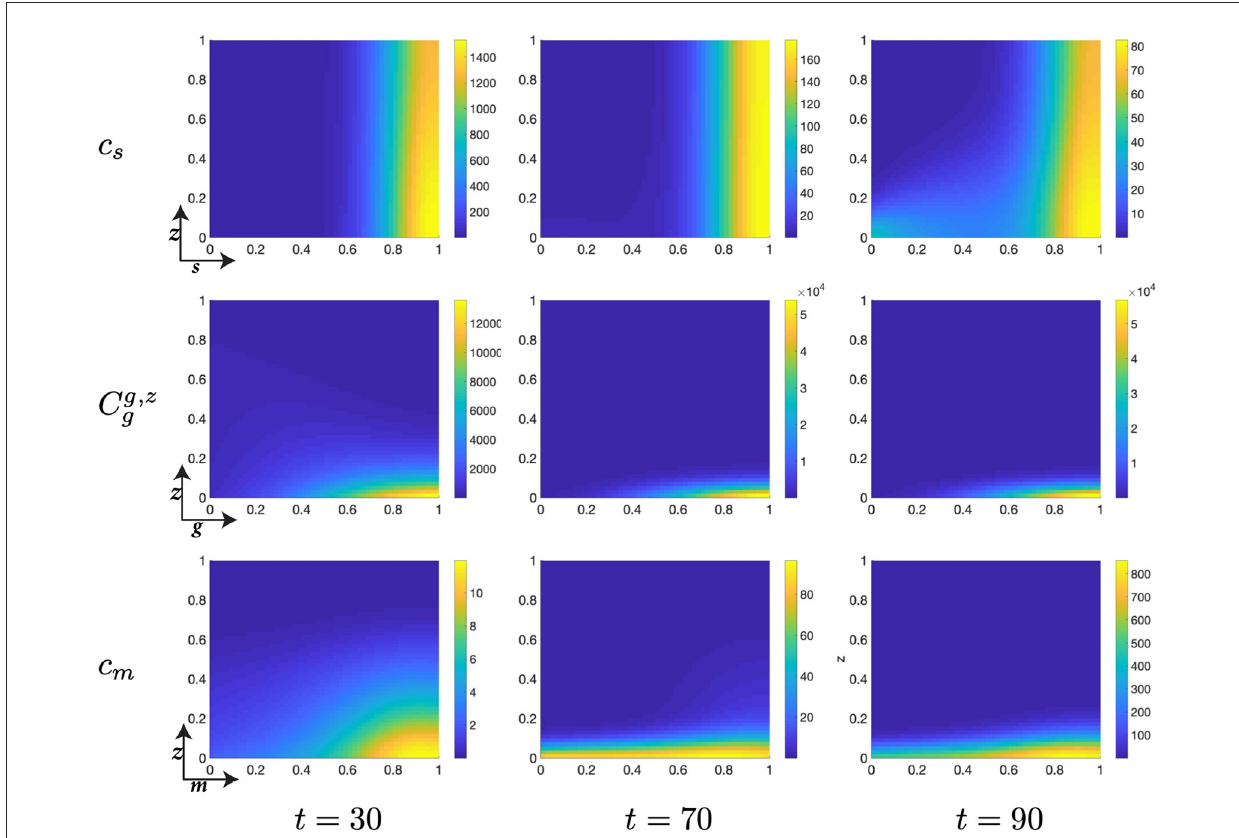
FIGURE7 Structured cell populations with S-cyclins ( s ) and DNA-damage ( z ), given in the S-phase ( c s ); G-cyclins ( g ) and DNA-damage ( z ), given in the G-phase ( C g , z g ); and M-cyclins ( m ) and DNA-damage ( z ), given in the M-phase ( c m ), solved for t